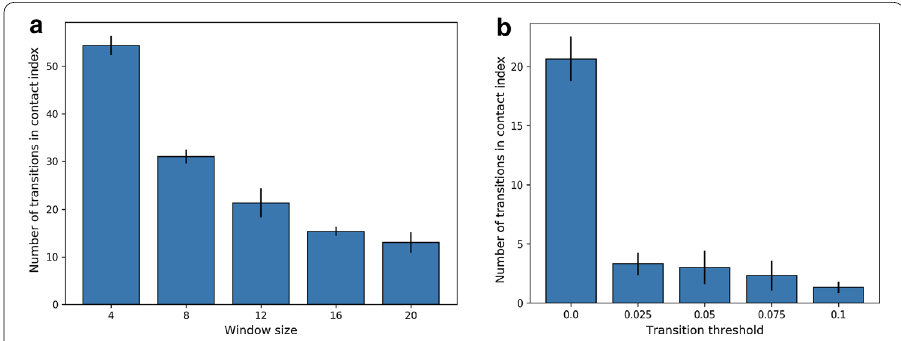
Fig. 6 Cost and criteria for lockdown duration: variation in contact index for the increase in the a lockdown transition window τ and b threshold α